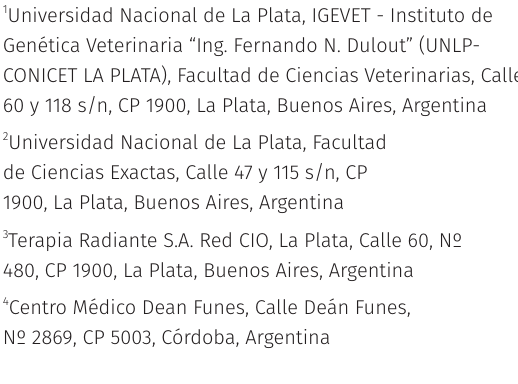
Table SI. Patient information. Patients are grouped according to the type of treatment they underwent CRT, HRT or SBRT. Data are shown for: Age (years); tumor Stage and Anatomopathology classification; patient Follow-up time after treatment (days); irradiation procedure in Number of fractions, Dose by fraction and Total dose (Gy); and if the patient had any type of Toxicity derived from the treatment (dermatological, respiratory, neurological or gastrointestinal), classified according to